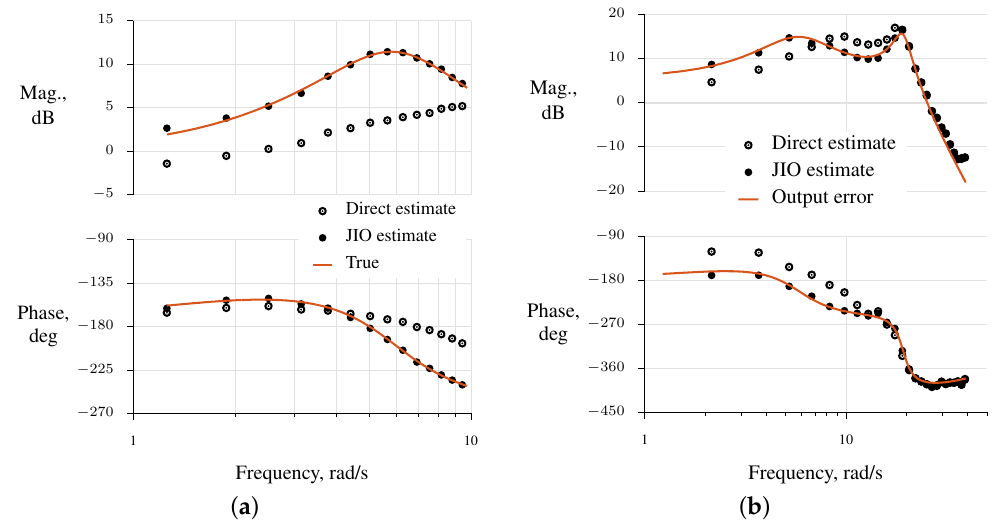
Figure 5. Examples of identifying bare-airframe dynamics from closed-loop data with the joint input–output approach vs. the direct approach: ( a ) T-2 simulation data for outer elevator to pitch rate frequency response; ( b ) X-56A flight test data for outer symmetric wing flap to forward pitch rate gyro frequency